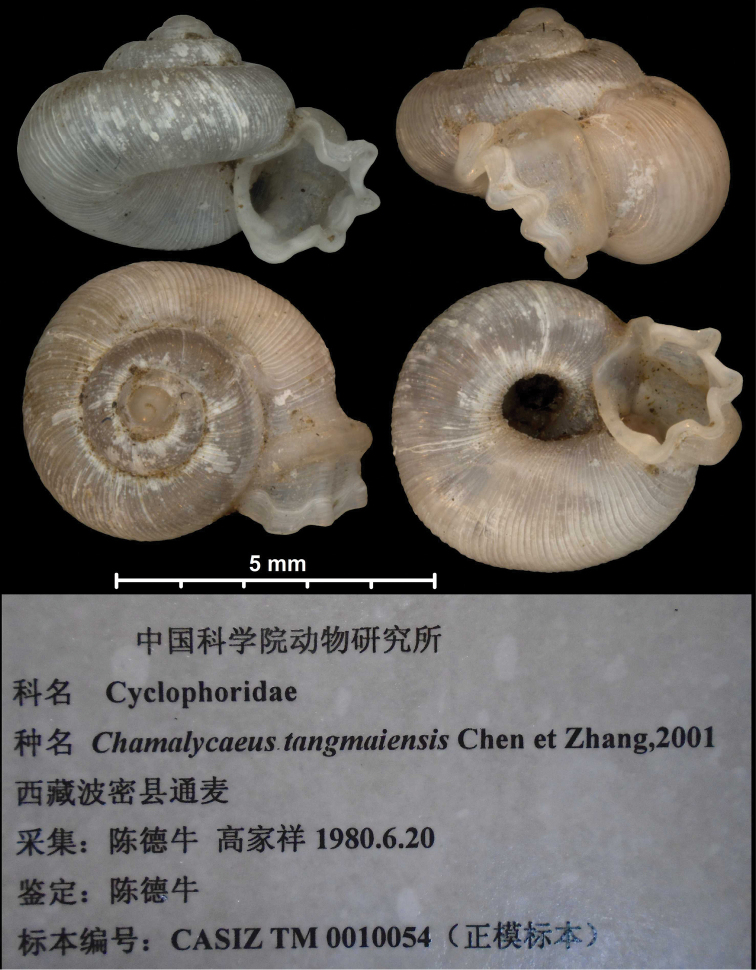
Dicharax
tangmaiensis (Chen & Zhang, 2001), holotype (CASIZ TM 0010054). Photographs: Kaibaryer Meng.